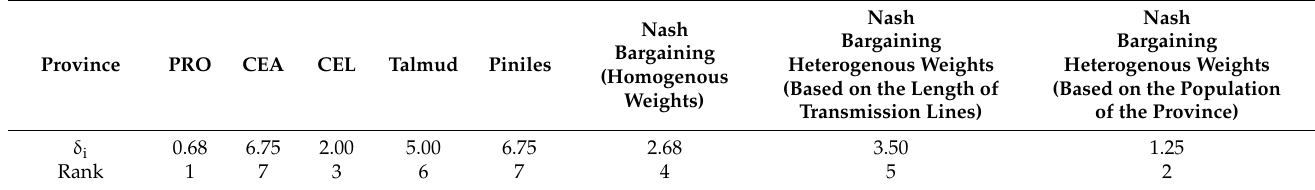
Table 6. Ranking of the power allocation rules (bankruptcy and Nash bargaining